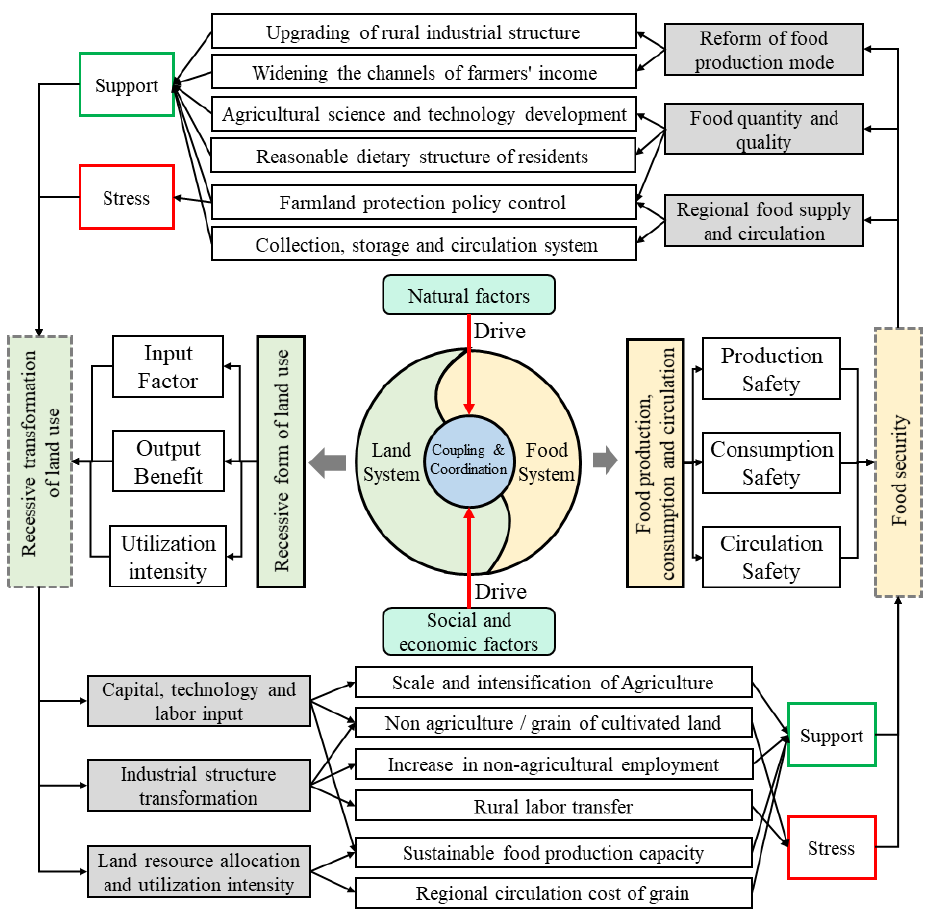
Figure 1. Mechanism of coupling coordination between RLUT and FS.